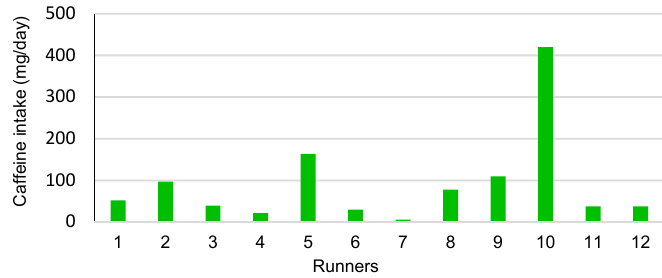
Figure 1. Habitual caffeine intake (mg/day) among runners.